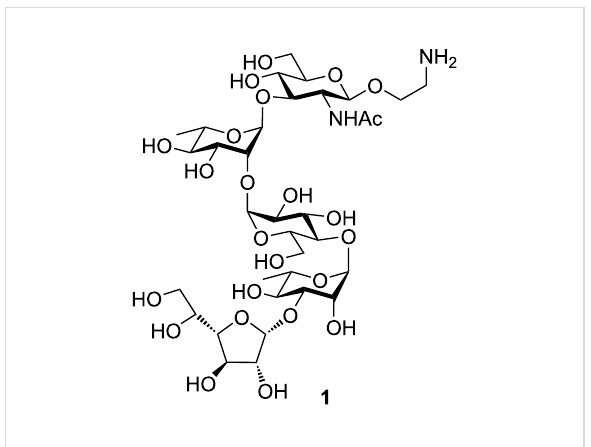
Figure 1: Structure of the target pentasaccharide repeating unit in the form of its 2-aminoethyl